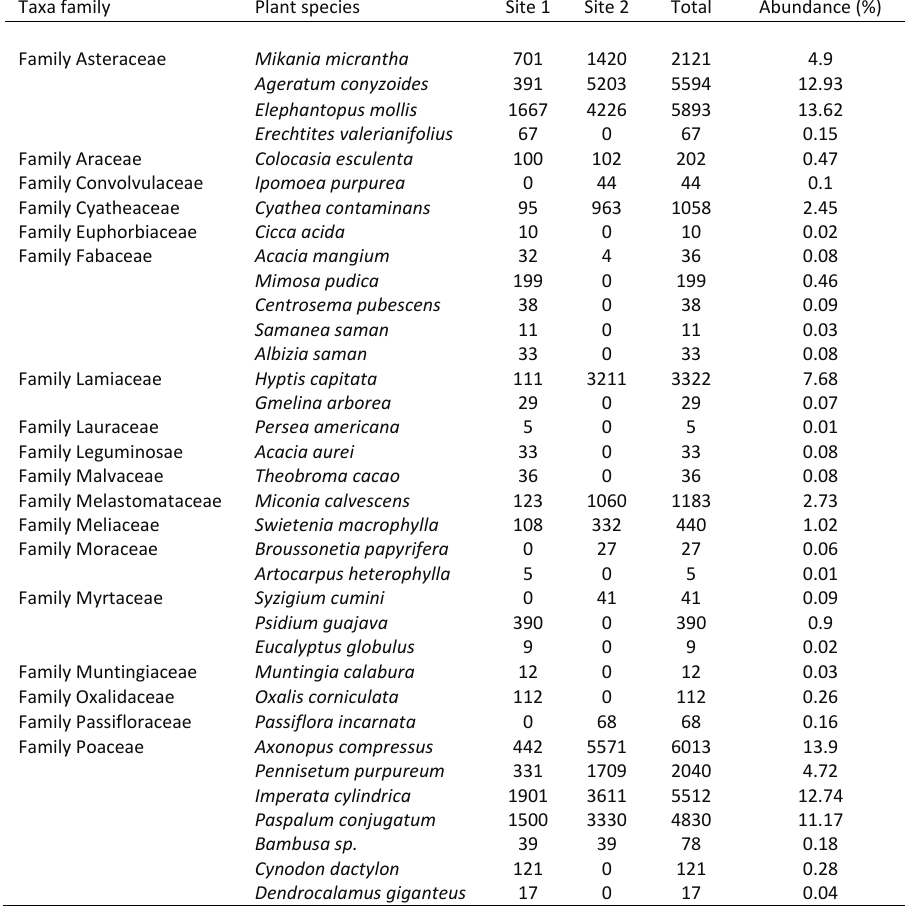
Table 1: List of all native and alien species surveyed in Site 1 and Site 2 of Mt. Manunggal, Cebu Island, Philippines Taxa